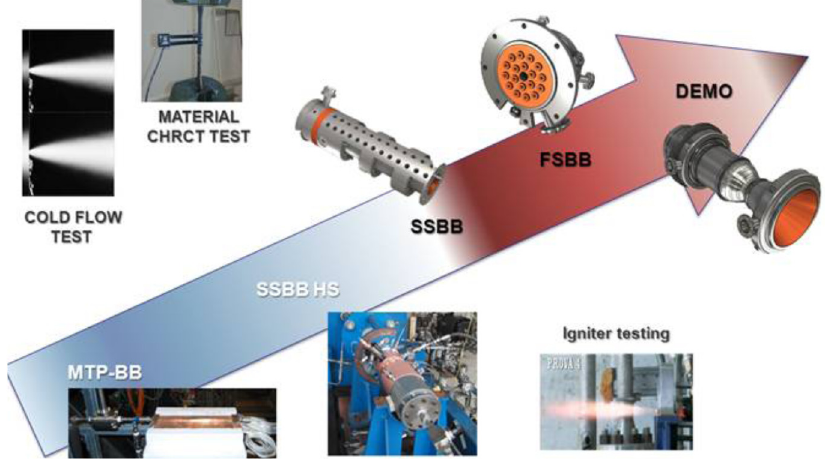
Figure 1. Logical steps of LO X /CH 4 demonstrator (DEMO) development.